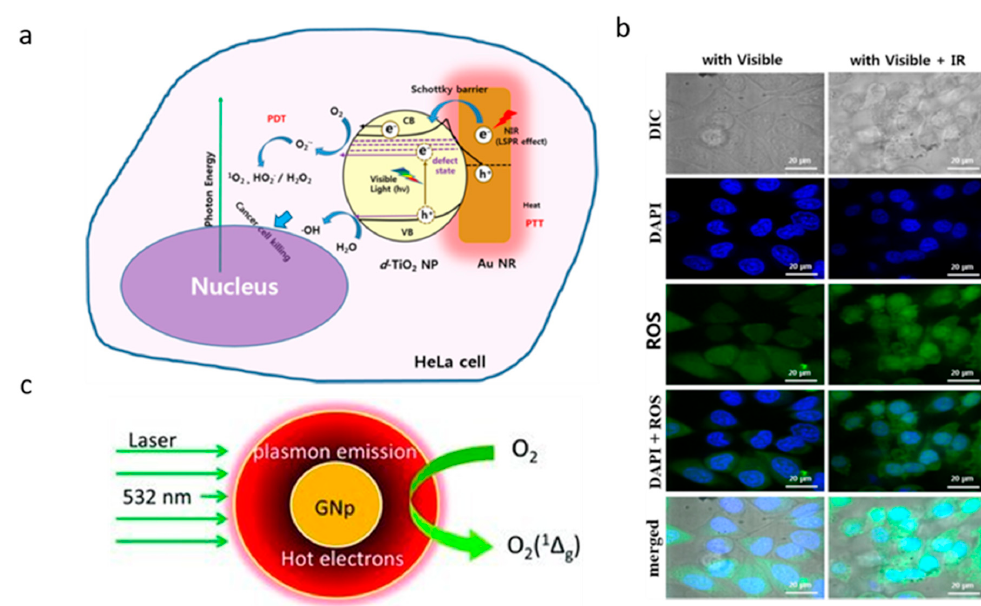
Figure 4. Mechanisms of hot electron generation by Au NPs and their applications. ( a ) Mechanism for the treatment of HeLa cells under visible and NIR radiation using TiO 2 Au NR conjugates. ( b ) A combination of visible and IR radiation shows stronger green fluorescence than visible light only, implying enhanced reactive oxygen species (ROS) generation by synergistic effect of visible light and heat generation, leading to high cell death efficacy. (Adapted from Lee et al. [180]). ( c ) Schematic of singlet oxygen generation upon laser irradiation of naked Au NPs. (Adapted from Pasparakis et al. [181]).